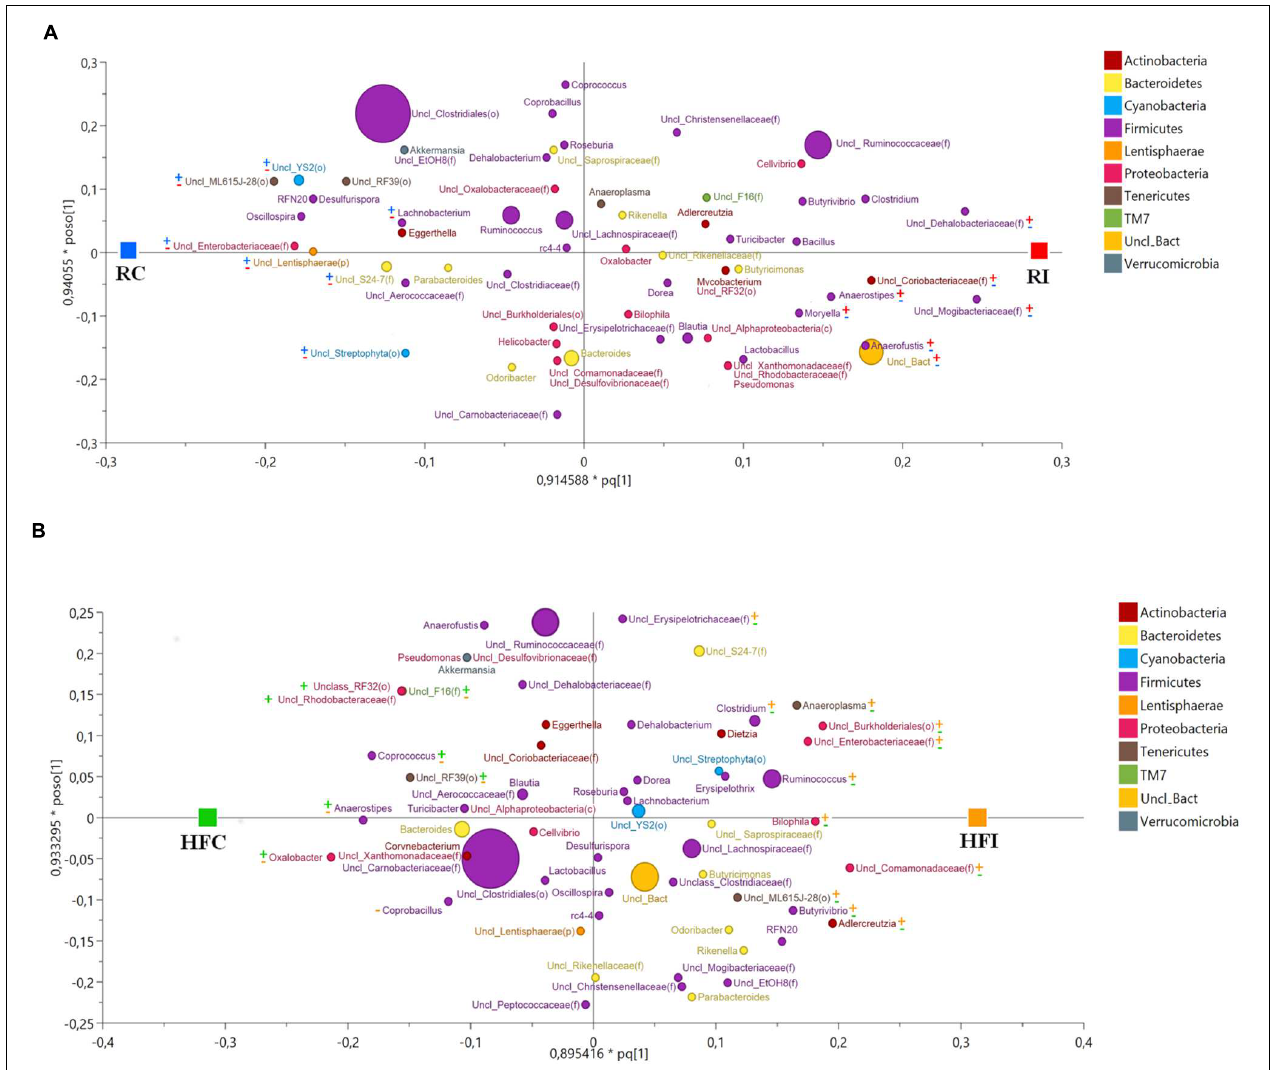
FIGURE 4 | Cecal content microbiota orthogonal projection to latent structures discriminant analysis (OPLS-DA) scatter plot. The size of the spheres represents abundance. (A) OPLS-DA Scatter Plot for cecal content samples of animals fed with regular diet ( R 2 Y = 1; Q 2 = 0.678). The taxa with significant positive association with MAP infected animals are labeled with ( + ) and with negative association with MAP infected animal with ( − ). The taxa with significant positive association with control animals are labeled with ( + ) and with negative association with control animals with ( − ). (B) OPLS-DA scatter plot for cecal content samples of animals fed with high fiber diet ( R 2 Y = 0.988; Q 2 Y = 0.733). The taxa with significant positive association with MAP infected animals are labeled with ( + ) and with negative association with MAP infected animal with ( − ). The taxa with significant positive association with control animals are labeled with ( + ) and with negative association with control animals with ( −